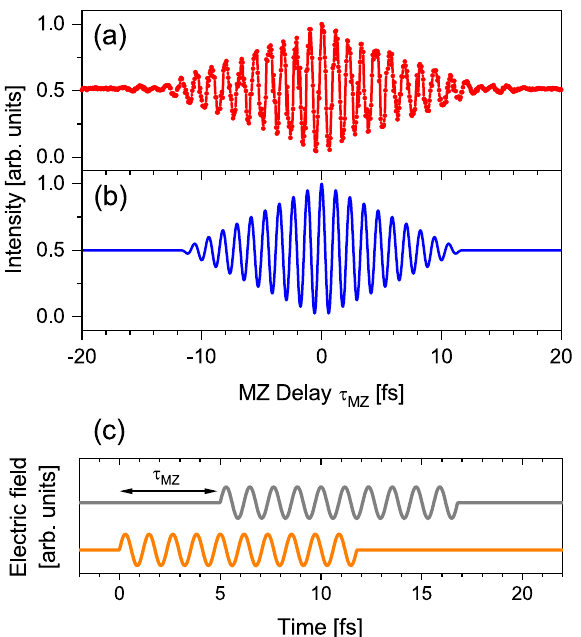
Figure 1. Autocorrelation measurement of spontaneous radiation from the downstream undulator. The wavelength of the fundamental undulator radiation was set to 357 nm. ( a ) Measurement. ( b ) Calculated autocorrelation function assuming a 10-cycle sinusoidal wave at 357 nm wavelength. ( c ) Waveform of the wave packet (orange) and its delayed replica (gray) used in the calculation. As an example, the waveform for MZ delay τ MZ = 5 fs is